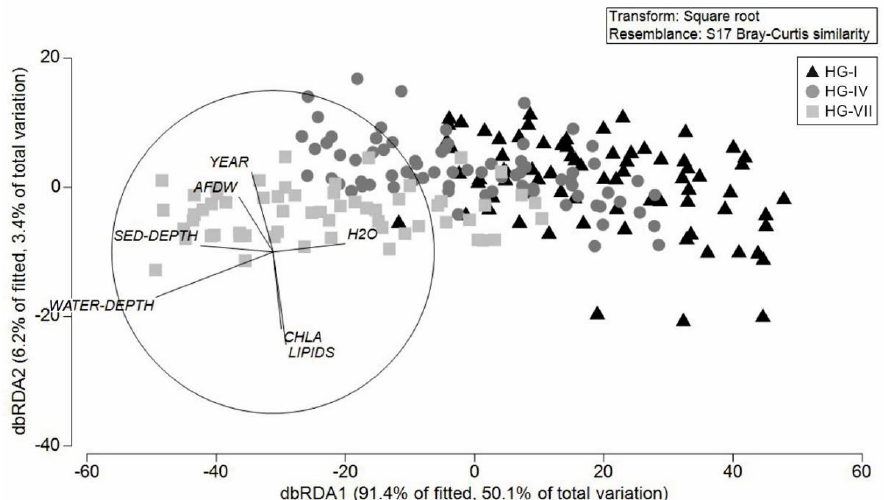
Figure 7. Distance-based redundancy analysis (dbRDA) ordination to investigate the relationship between the environmental variables and meiofauna communities (R 2 adj = 0.47; R 2 = 0.48); H 2 O: water content, AFDW: total organic matter, CHLA: chlorophyll a , LIPIDS: phospholipids, SED-DEPTH: sediment depth, WATER-DEPTH: water depth, YEAR: sampling year (length of overlying vectors according to the strength of correlation between the certain parameter with the first and second dbRDA axis,